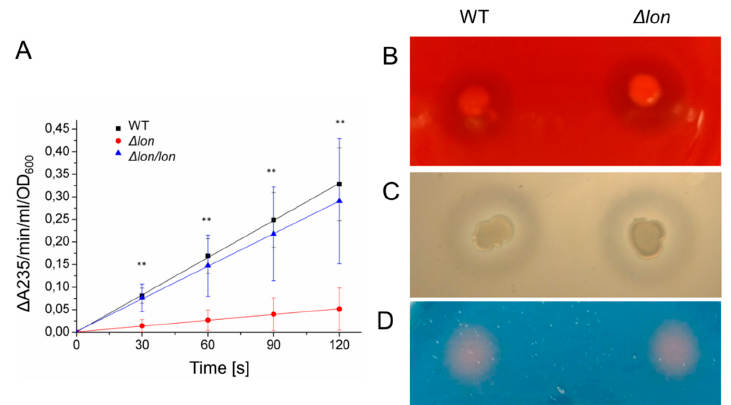
Figure 6. The activity of secreted virulence factors. ( A ) Pectinase activity was assayed as described in the Methods section with PGA as a substrate at 30 ◦ C. ** p < 0.01 ( t -test), n = 5. ( B ) Cellulases were assayed on M63Y with CMC. Seven microliters of bacterial cultures (10 8 CFU / mL) were spotted on the medium and incubated for 72 h. Plates were stained with 2% Congo red solution. ( C ) To monitor protease activity, 7 µ L of bacterial cultures (10 8 CFU / mL) were spotted onto LA with skimmed milk and incubated for 48 h. ( D ) Siderophore activity was determined by spotting 10 µ L of supernatant from overnight grown bacteria cultures onto chrome azurol S-agar plates. The picture was taken after 1 h of incubation at 30 ◦ C. The experiments ( B – D ) were performed at least five times. The representative results are